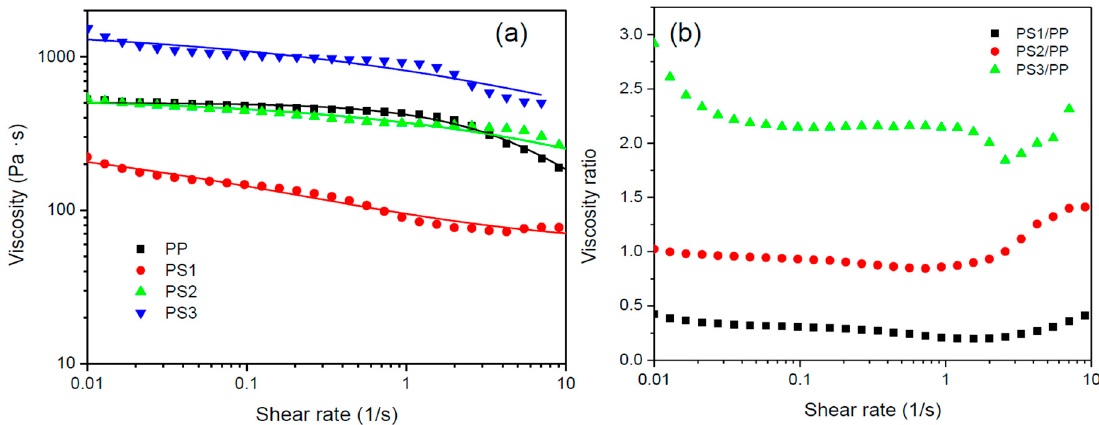
Figure 2. The shear viscosities of polymers ( a ) and viscosity ratio of polymer blends; ( b ) as a function of shear rate.